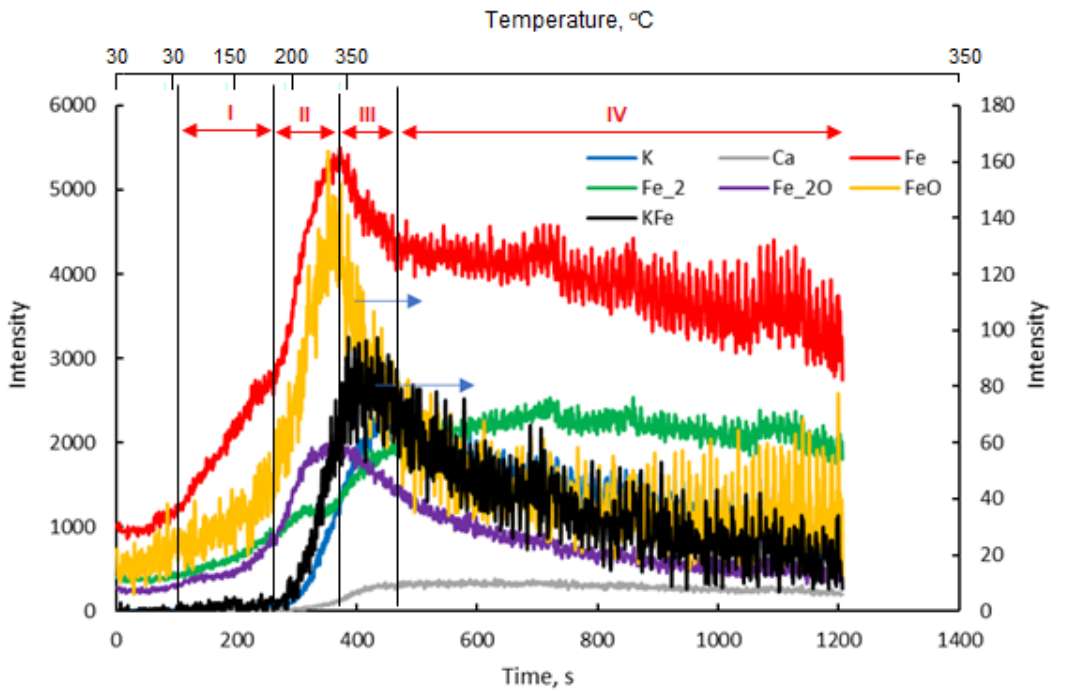
Figure 6. Temperature-programmed TOF-SIMS profile of the Fe-Ca sample.